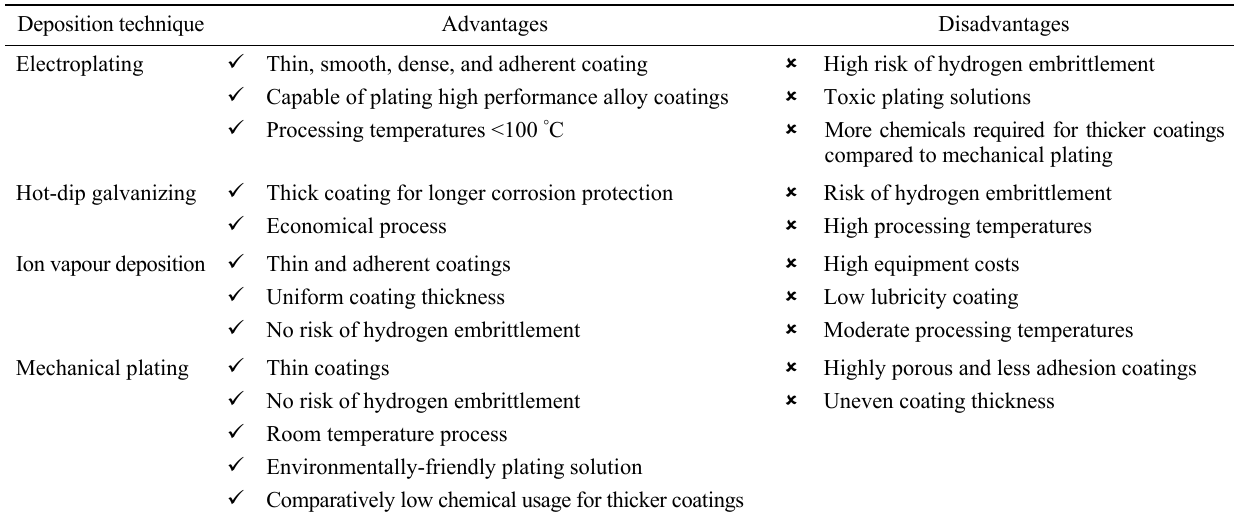
Table 1 Summary of the advantages and disadvantages for different coating deposition